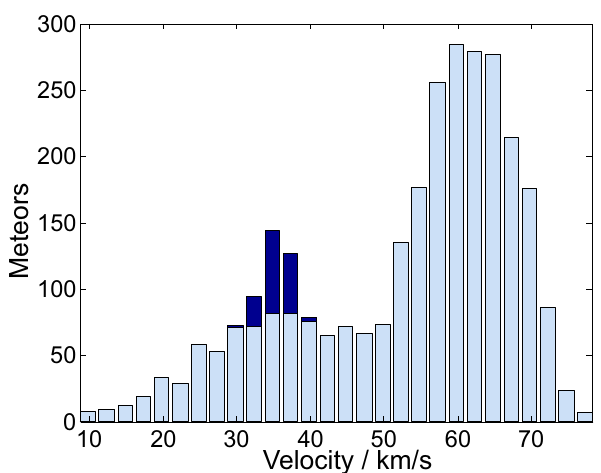
Fig. 9. Histogram of the velocity distribution; dark blue bars corre- sponds to Geminid meteors; light blue bars for sporadics.